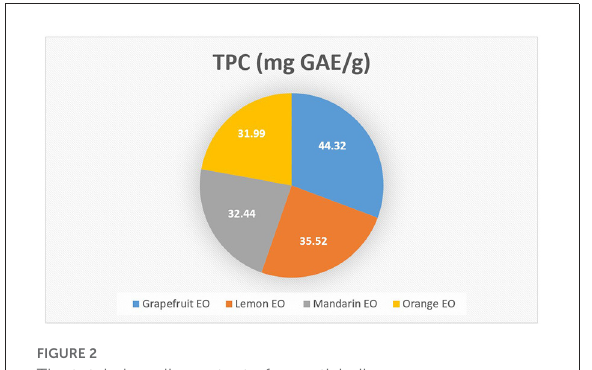
FIGURE2 The total phenolic content of essential